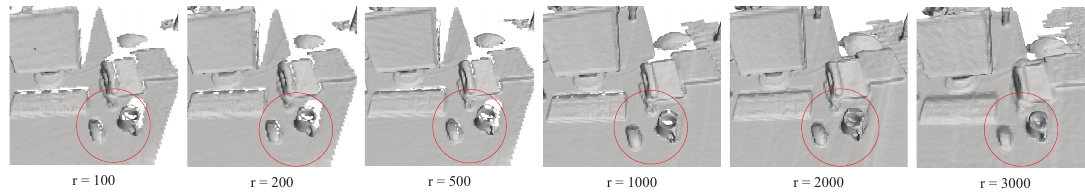
Figure 4. The enlarged views of reconstruction results with different numbers (100, 200, 500, 1000, 2000 and 3000) of camera views on the fr2_xyz sequence of the TUM RGB-D